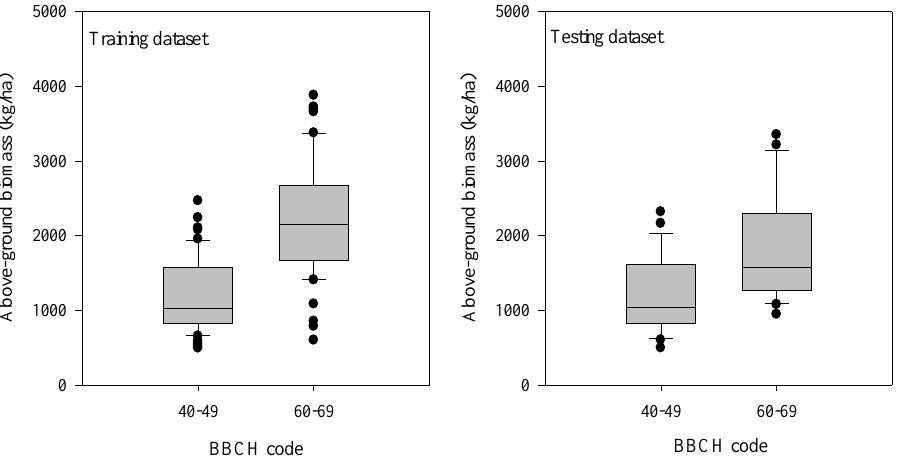
Figure 2. Variation of the above-ground biomass of potato at tuber formation and tuber bulking stages. The distribution is characterized by box-and-whisker plots, where the boxes show the 25th and 75th percentiles and the whiskers the 10th and the 90th percentiles. The median is represented by the line in the box and is provided as a number above the box plot.